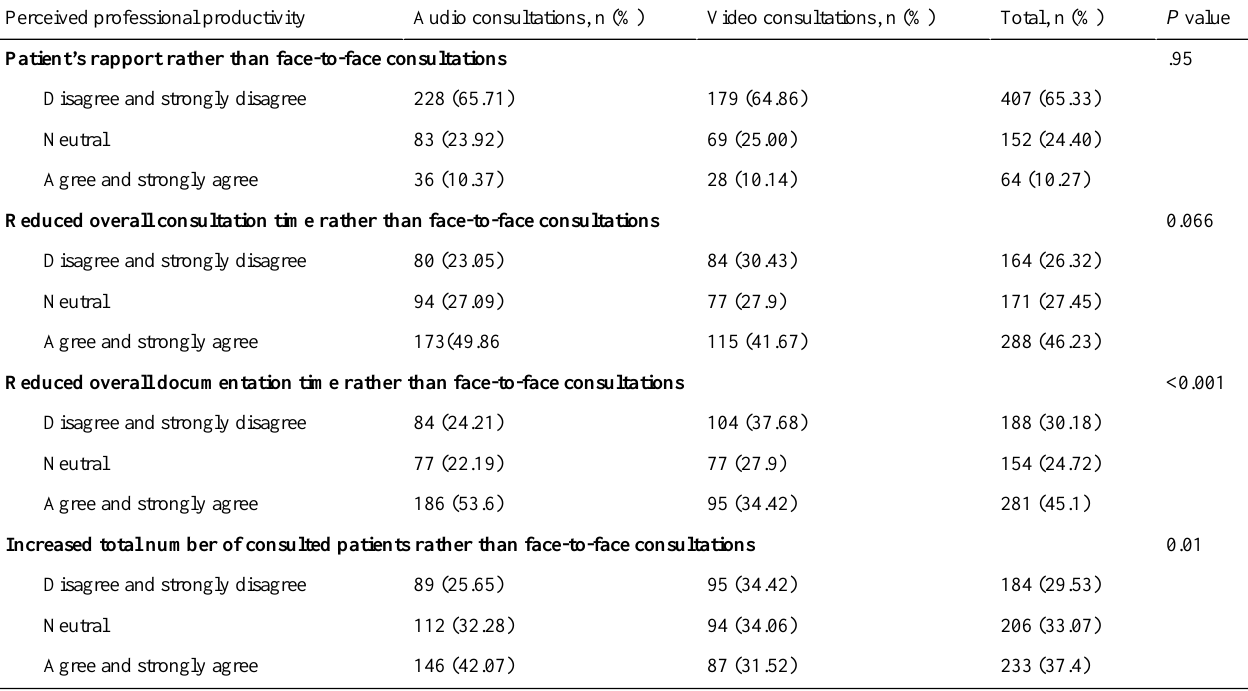
Table 3. Comparison of survey responses on perceived professional productivity by